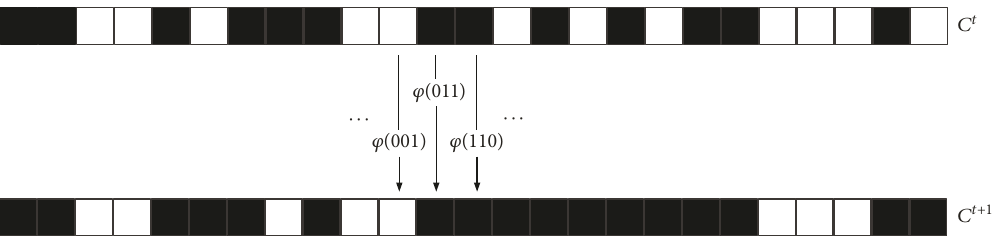
Figure 2: Example of the evolution of a one-dimensional cellular automaton with n = 3 and states 0 and 1 depicted as white and black squares, respectively.